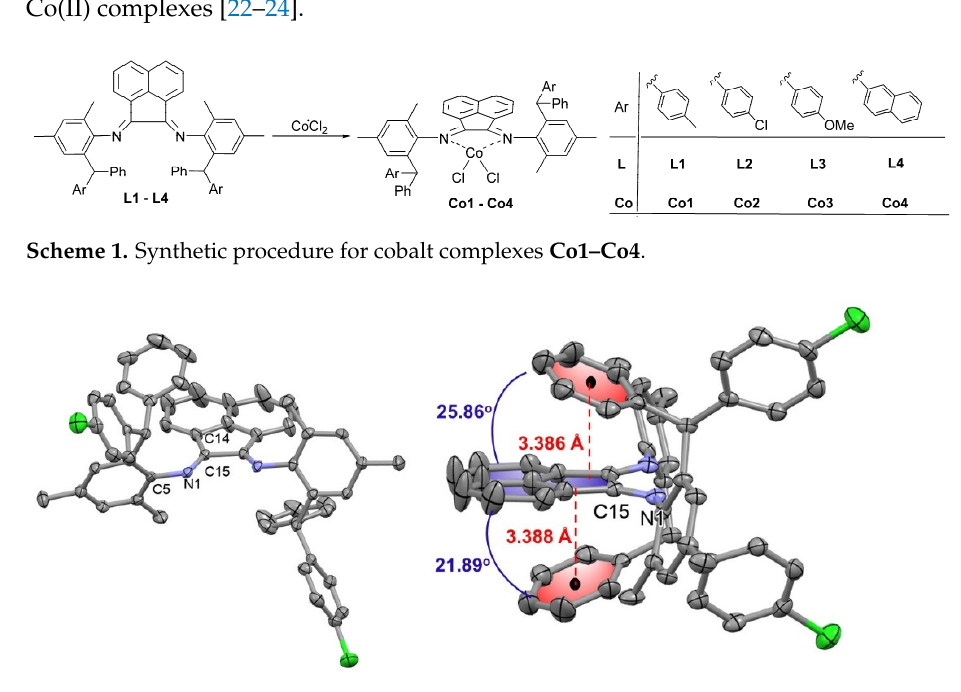
Figure 1. ORTEP drawing of complex L2 with thermal displacement parameters at 50% probability. Bond lengths (Å): N1-C15, 1.268(5), N1-C5, 1.420(5). Bond angles (deg): C5-N1-C15, 122.97(3).